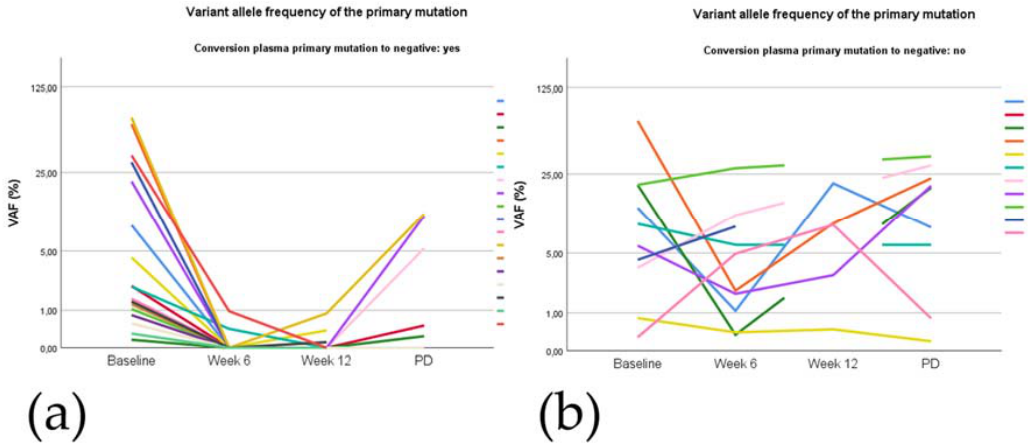
Figure 3. Variant allele frequency (VAF) of the primary EGFR mutation in time, by plasma